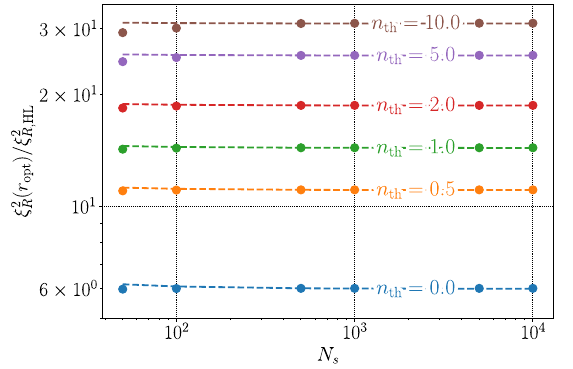
FIG. 17. Ratio between the minimum steady-state Wineland parameter obtained by solving the mean-field equations of motion for the system governed by Eq. (K1), and the ideal Heisenberg-limited value ξ 2 ¼ 2 = ð N þ 2 Þ . Each dot corre- R; HL sponds to a solution with optimized squeezing strength r , while the dashed curves are fits to a horizontal line (taken over the largest four values of N for each n th